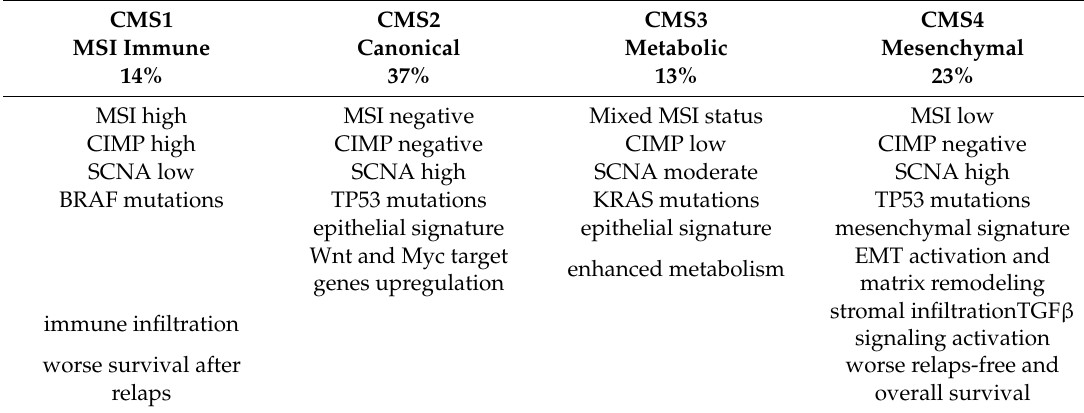
Table 1. Biological characteristics of consensus molecular subtype (CMS) groups of colorectal tumors. CMS1 CMS2 CMS3 CMS4 MSI Immune Canonical Metabolic Mesenchymal 14% 37% 13% 23% MSI high MSI negative Mixed MSI status MSI low CIMP high CIMP negative CIMP low CIMP negative SCNA low SCNA high SCNA moderate SCNA high BRAF mutations TP53 mutations KRAS mutations TP53 mutations epithelial signature epithelial signature mesenchymal signature Wnt and Myc target EMT activation and enhanced metabolism genes upregulation matrix remodeling stromal infiltrationTGF β immune infiltration signaling activation worse survival after worse relaps-free and relaps overall